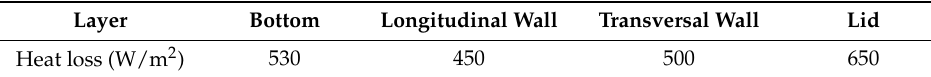
Table 4. Heat flux boundary condition parameters for the exterior walls [26].